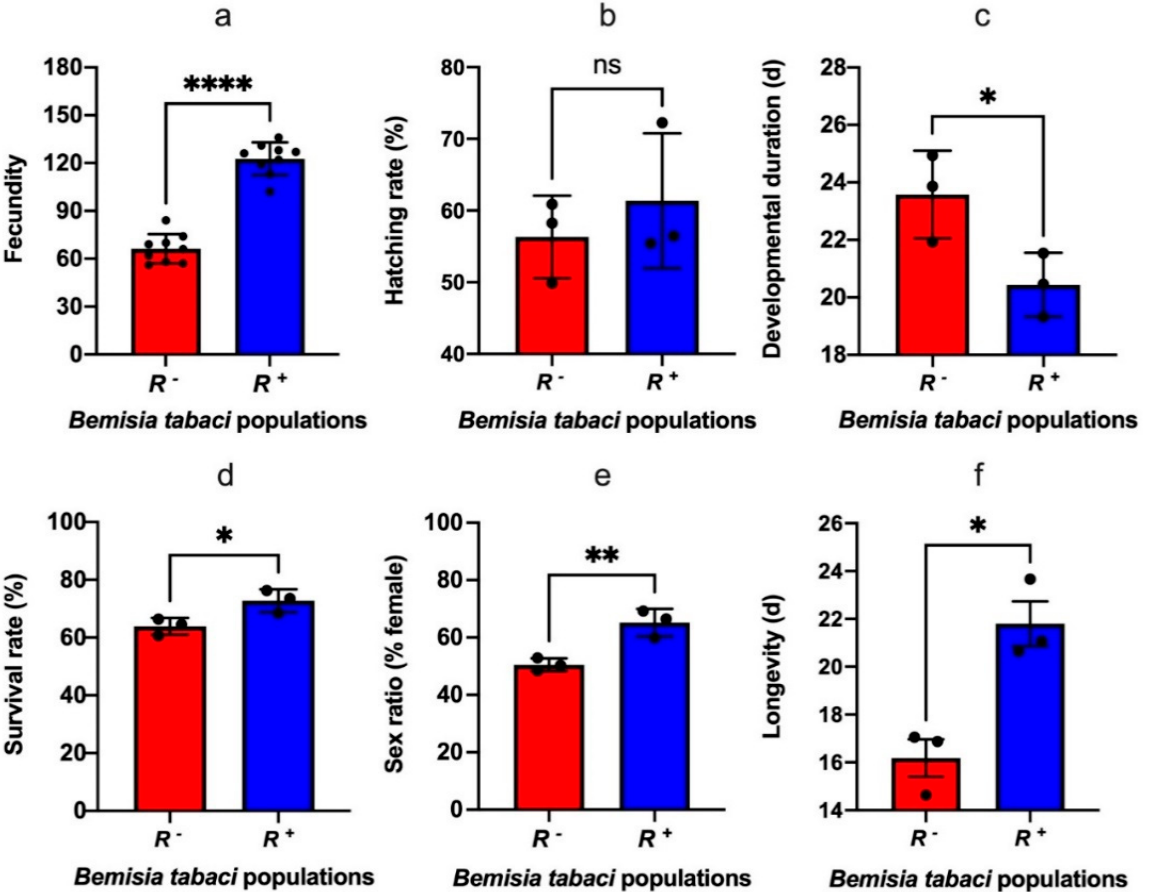
Figure 1. The effect of Rickettsia infection on the fecundity ( a ), hatching rate ( b ), developmental du- ration ( c ), survival rate from egg to adult ( d ), sex ratio (% female) ( e ) and longevity ( f ) of Bemisia tabaci MEAM1 cryptic species. R + : Rickettsia positive population; R − : Rickettsia negative population. Data were compared among treatments using t -test, and stars over the bars *, **, **** signify differences were significantly different at 0.05, 0.01 and 0.0001 levels respectively, ns signifies differences were not significant.